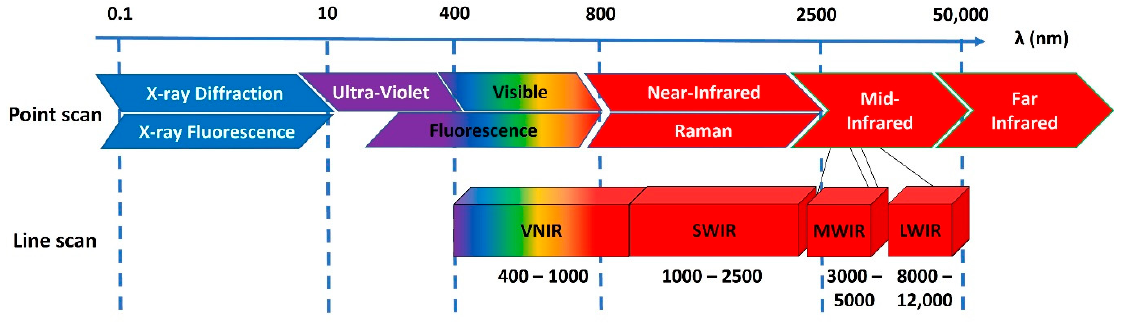
Figure 2. Electromagnetic spectrum and names of the main corresponding spectroscopic and hyperspectral techniques (VNIR: Visible and Near-Infrared, SWIR: Short Wave-Infrared, MWIR: Mid-Wave-Infrared, LWIR: Long-Wave-Infrared).